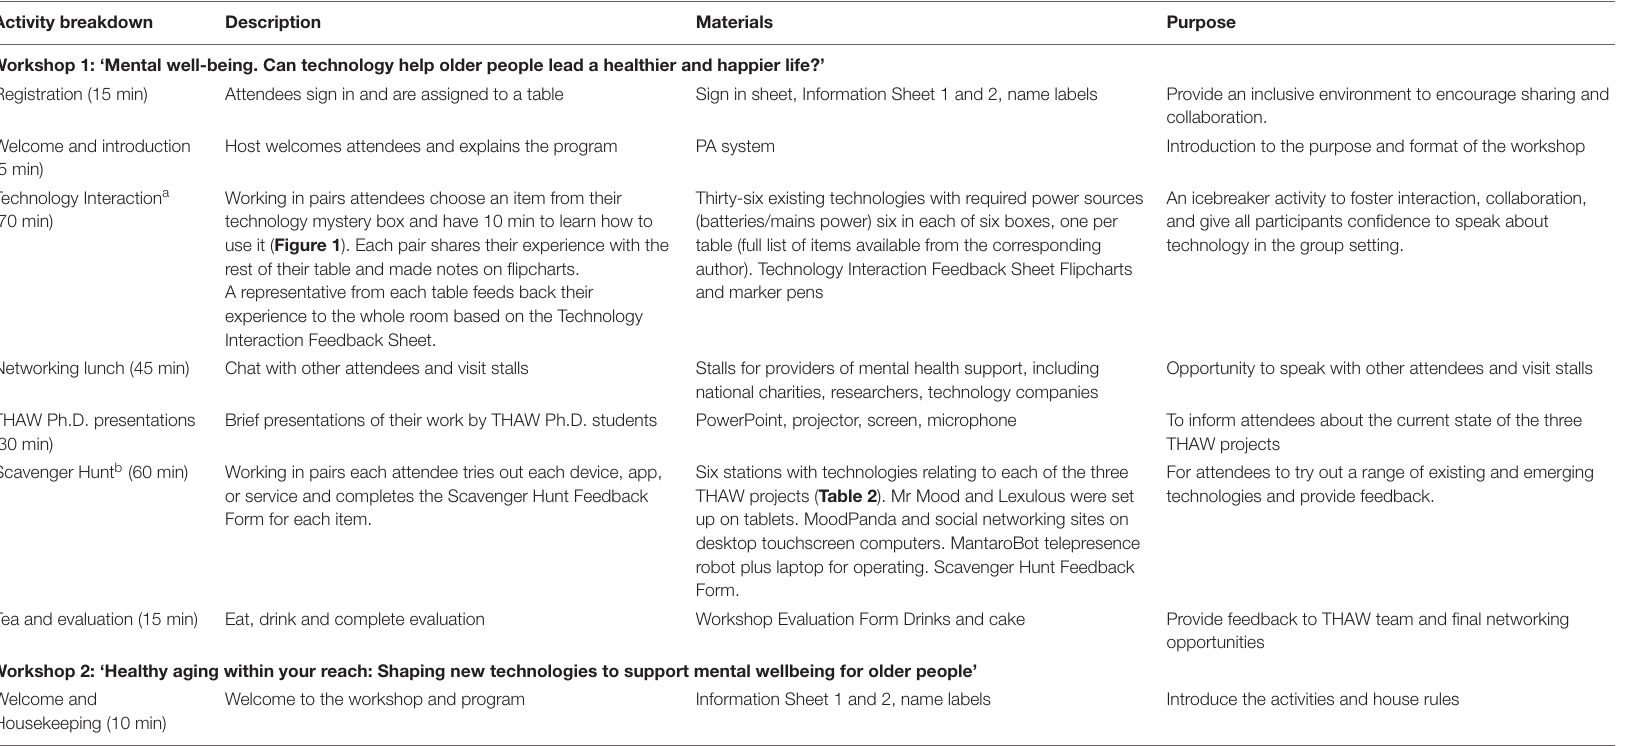
TABLE 1 | Design of THAW interactive